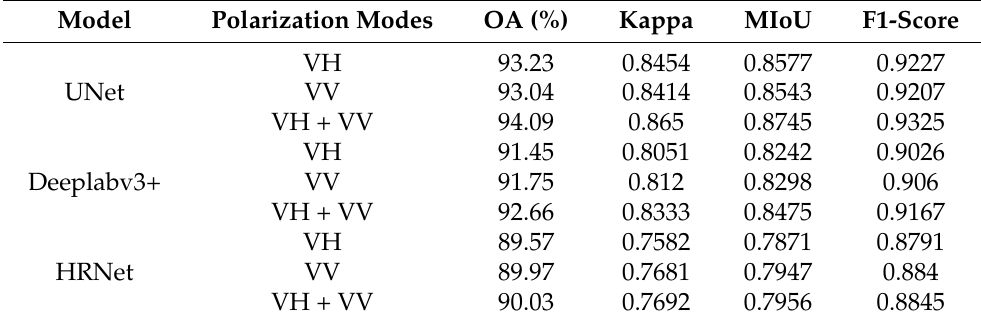
Table 6. Extraction accuracy for impervious surfaces with different polarization channels.